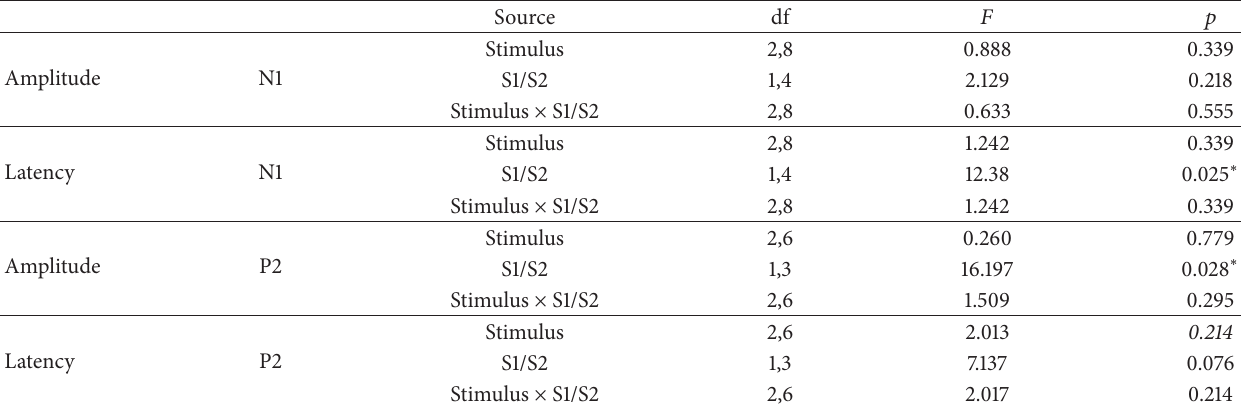
Table 3: Adults: comparisons of amplitude and latencies for the P1 and N1 components of the slow cortical response to S1 versus S2 elicited by /dada/, /daba/, and /daDa/ using two-way repeated measures analyses of variance. Source